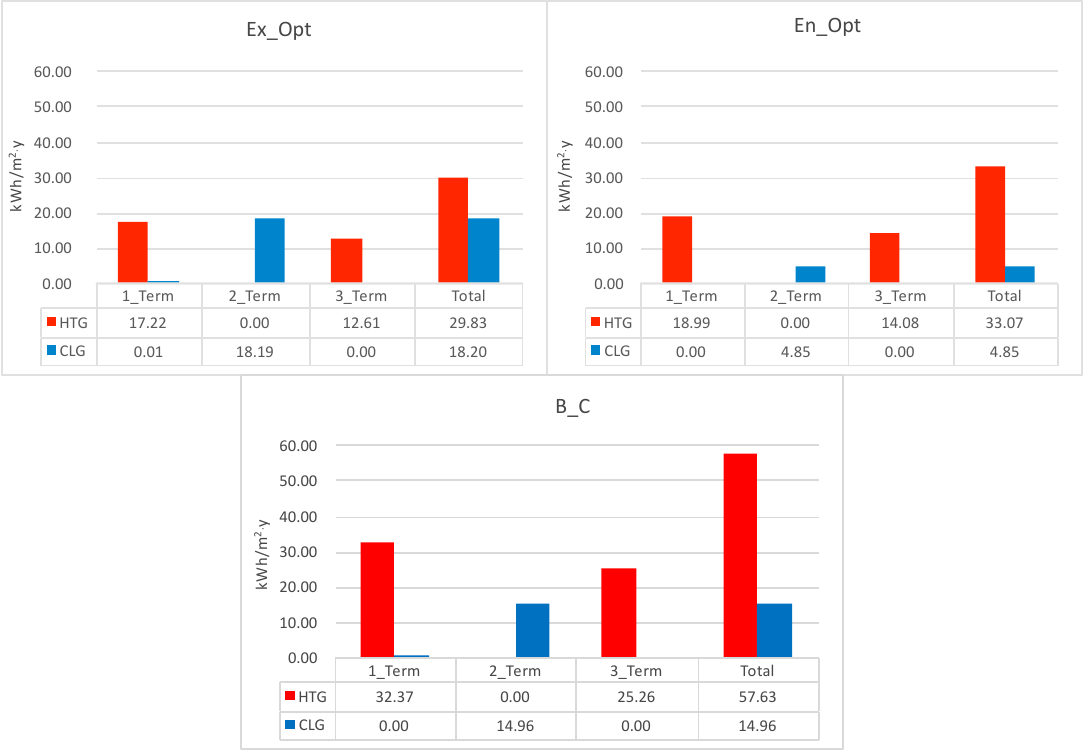
Figure 11. Energy